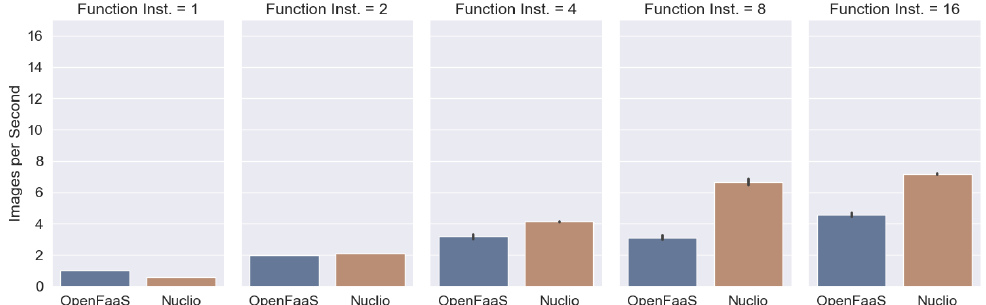
Figure 1. Image workload: OpenFaaS and Nuclio in comparison.